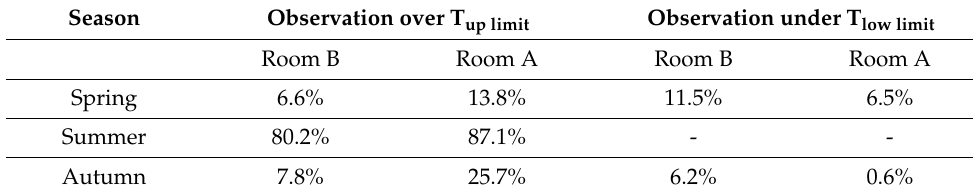
Figure 22. Adaptive model in spring, summer, and autumn periods. Table 6. Percentage of data out of adaptive model